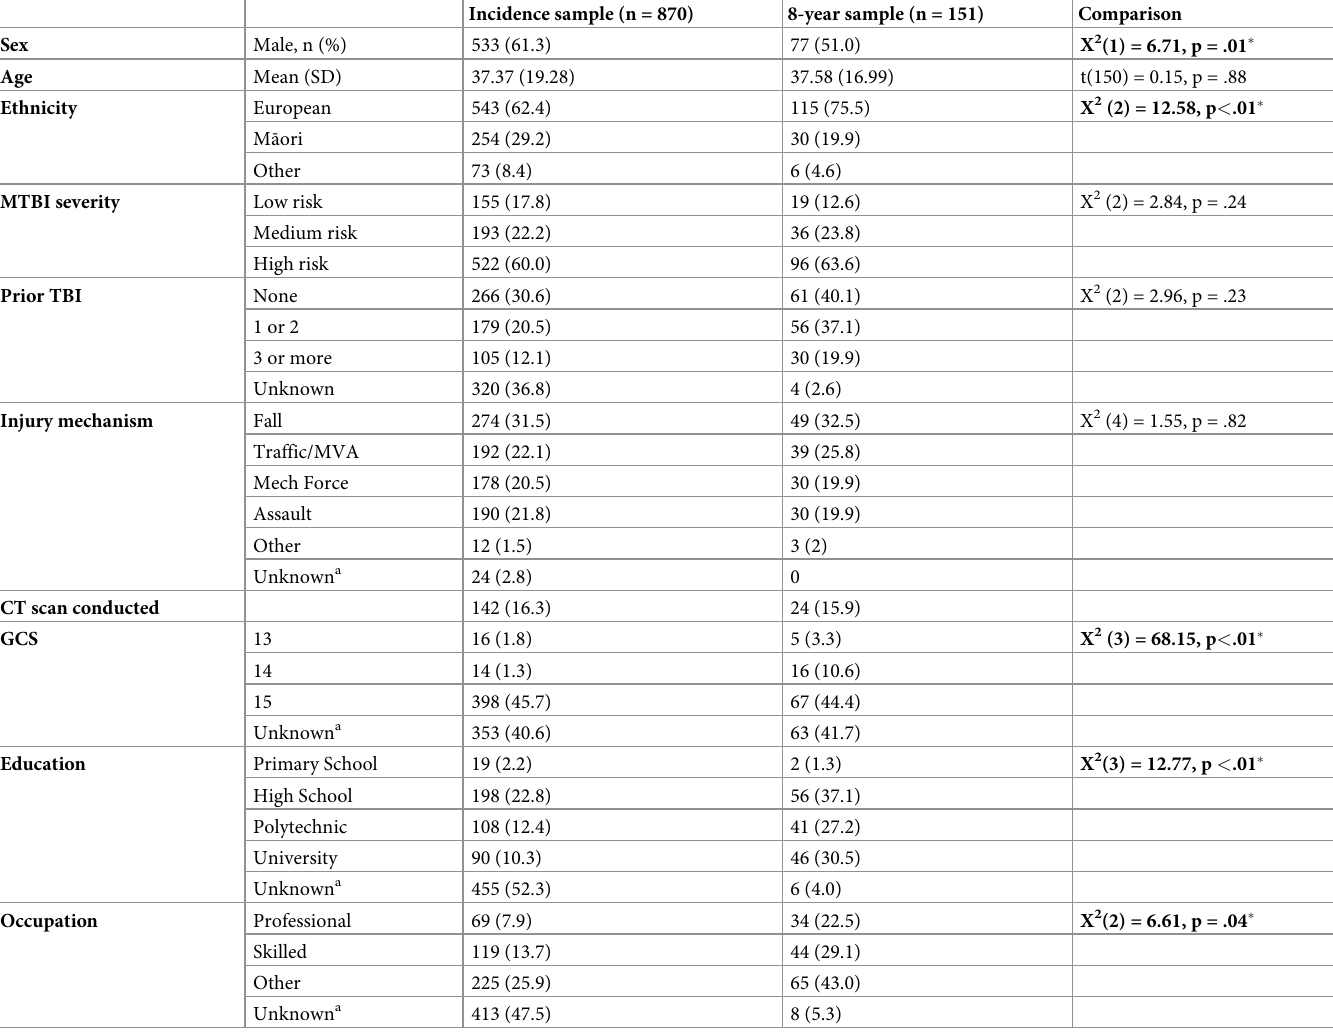
Table 1. A comparison of the demographic and injury characteristics of the Bionic incidence study cohort and the sample consenting to the 8-year follow-up. Mean (standard deviation) or number (percentage) of participants for demographic and injury variables for the TBI incidence cohort and the sample consenting to the eight year follow up. Chi-square goodness of fit tests were used to determine if the 8-year sample was representative of the incidence